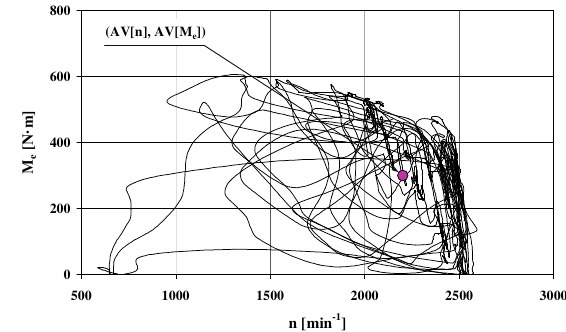
Fig. 4. Engine torque – M e vs. time – t curve, recorded in the BBDT test